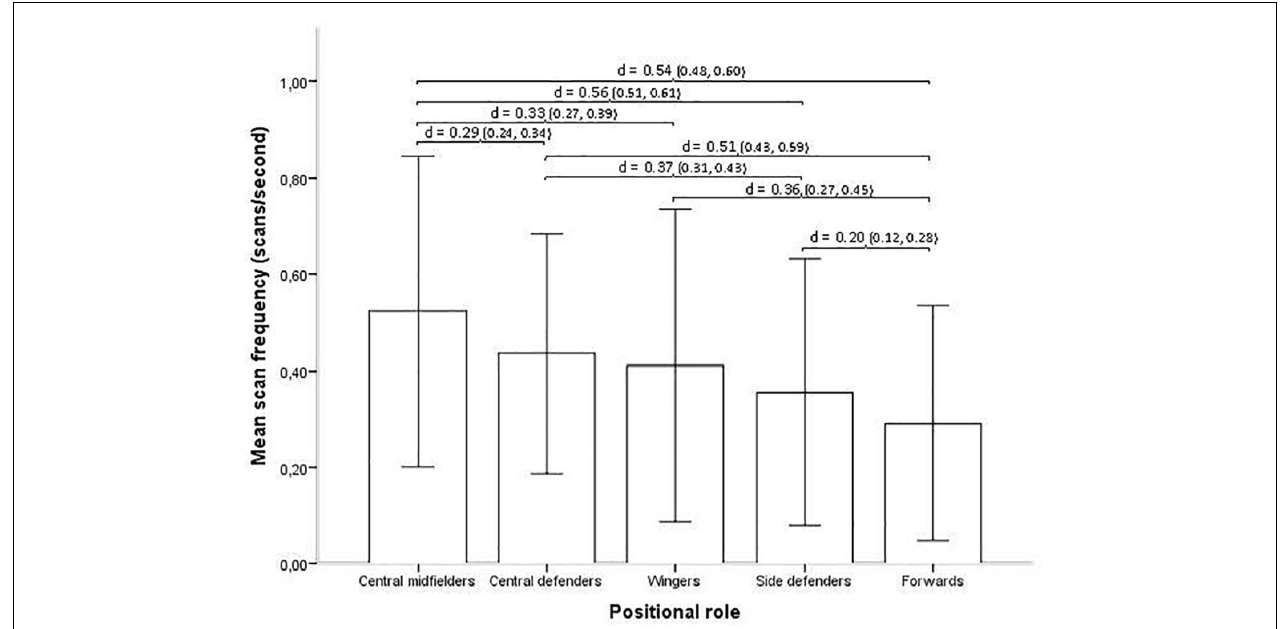
FIGURE 2 | Positional role and mean scan frequency (with SD error bars). Brackets indicate all significant relationships with an effect size > 0.20, with effect size d and 95% confidence interval (CI) in parentheses.